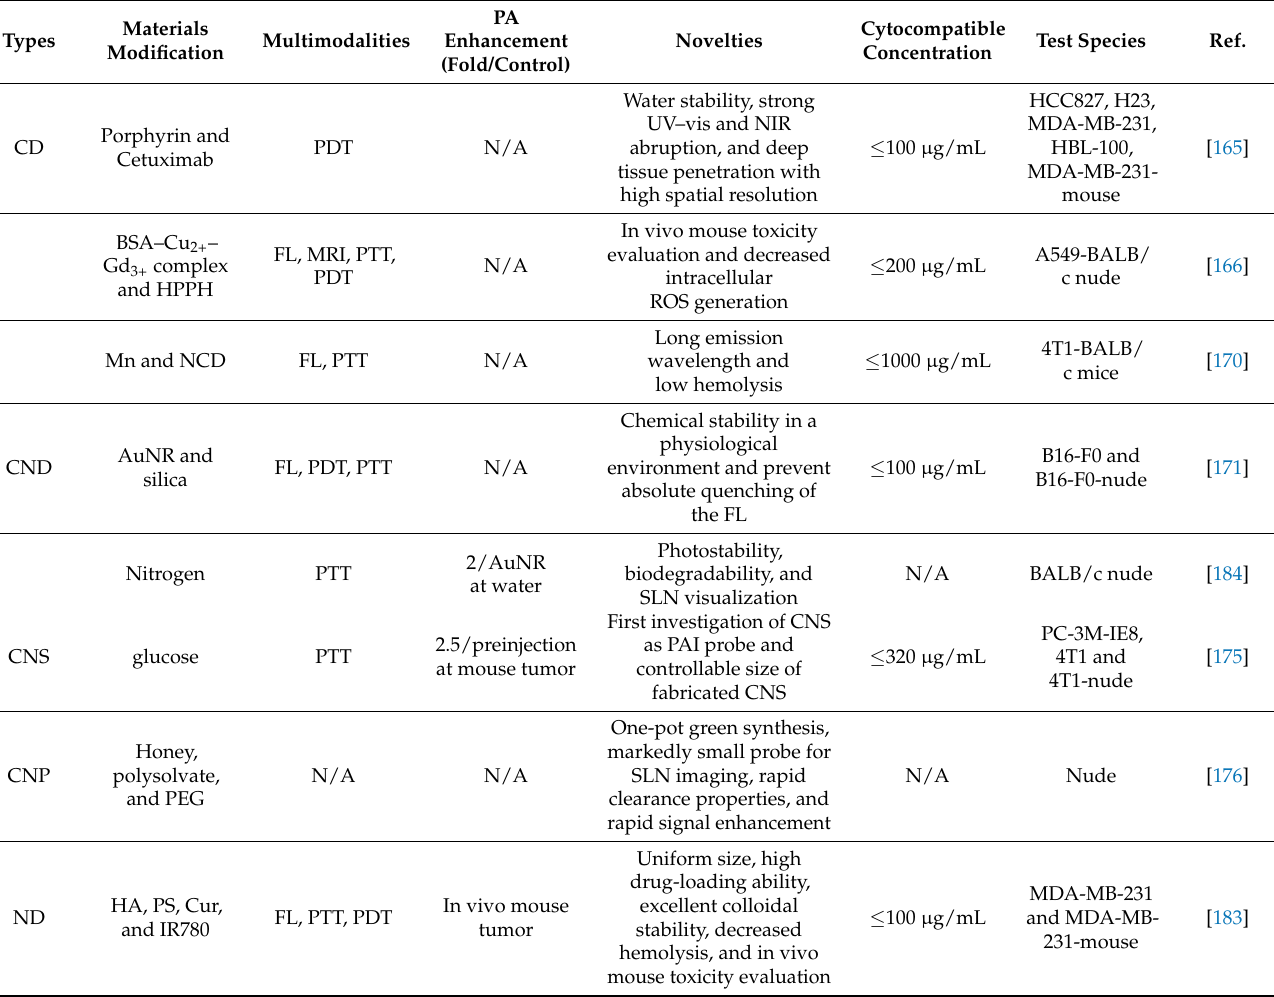
Table 4. CNP-based PAI. Each piece of research is classified by CNP types, modification, abbreviation, theragnosis multimodalities, PA signal enhancement, novelties, maximum cytotoxicity concentration, and test species. HER2, epidermal growth factor receptor 2; HPPA, 2-(1-hexyloxyethyl)-2-devinyl pyropheophorbide- α ; PS, protamine